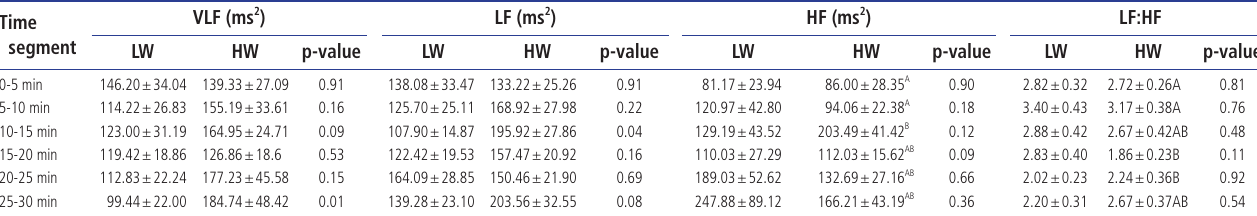
Table 5. Comparison in frequency-domain indexes between LW and HW groups during isolation